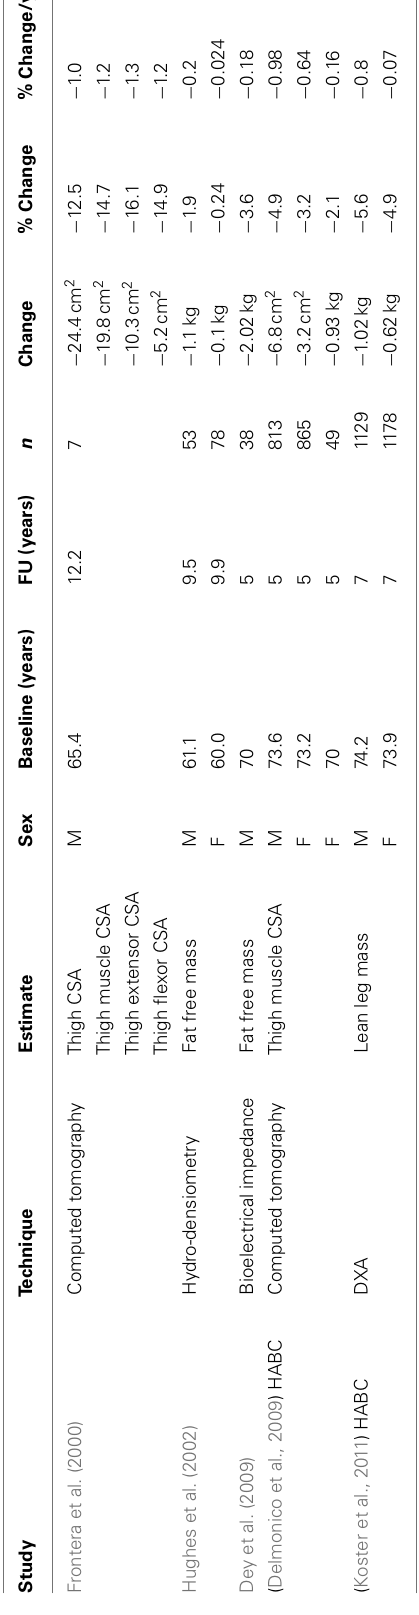
muscle (Janssen et al., 2000), supporting previous evidence from CT (Borkan et al., 1983) and DXA (Gallagher et al., 1997) based